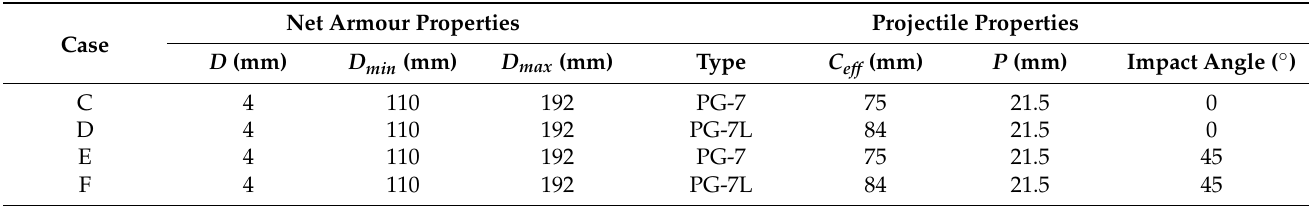
Table 3. Relevant metallic net armour and projectile properties.